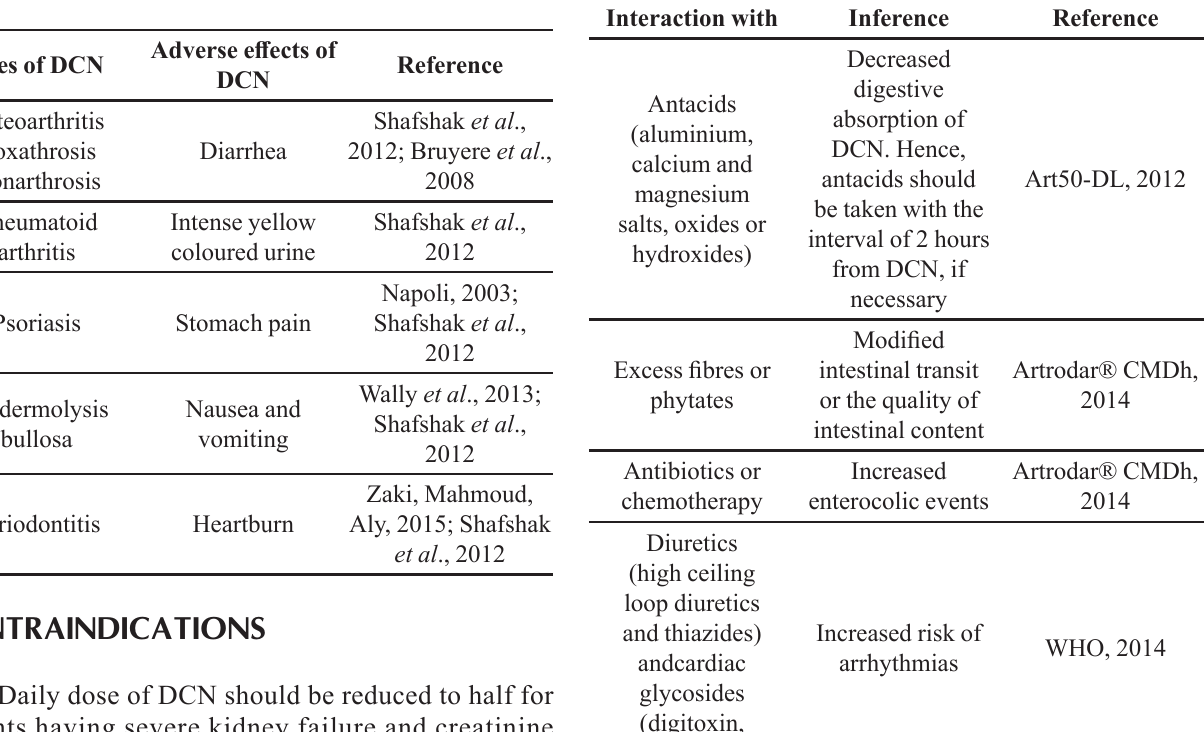
TABLE II - Uses and adverse effects of DCN Uses of